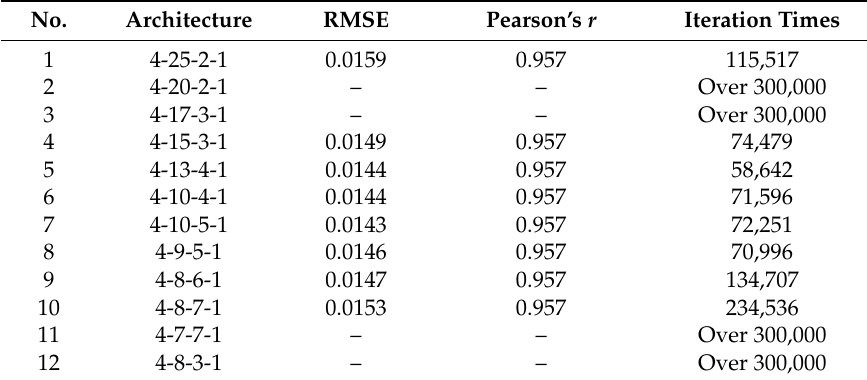
Table 9. Evaluation results of different